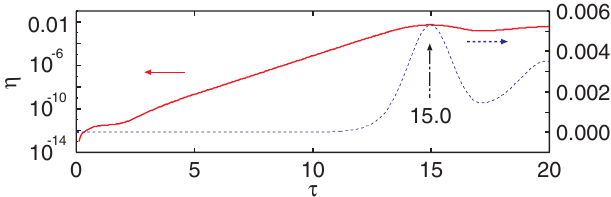
FIG. 8. (Color) Efficiency as a function of (cid:6) obtained in a simulation. The solid line is semilog plot, and the dotted line is linear plot. The simulation parameters are the same as in Fig. 6.